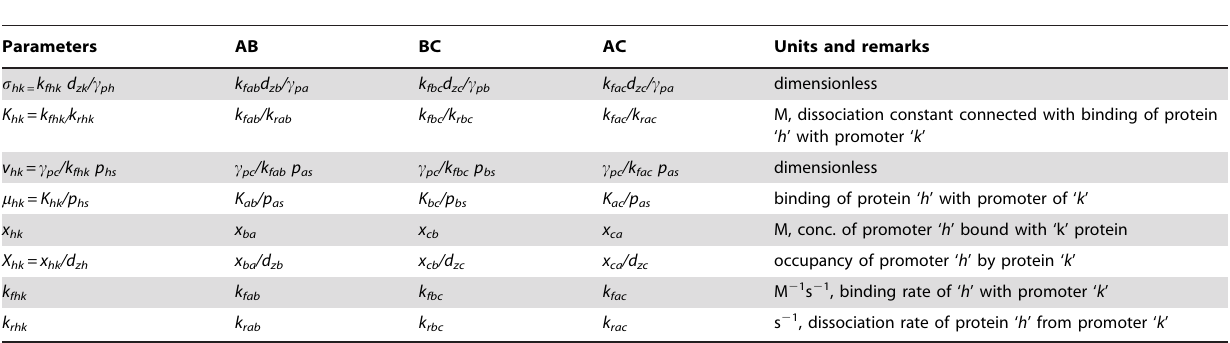
Table 2. Parameters used to describe the interactions between various components of FFLs.